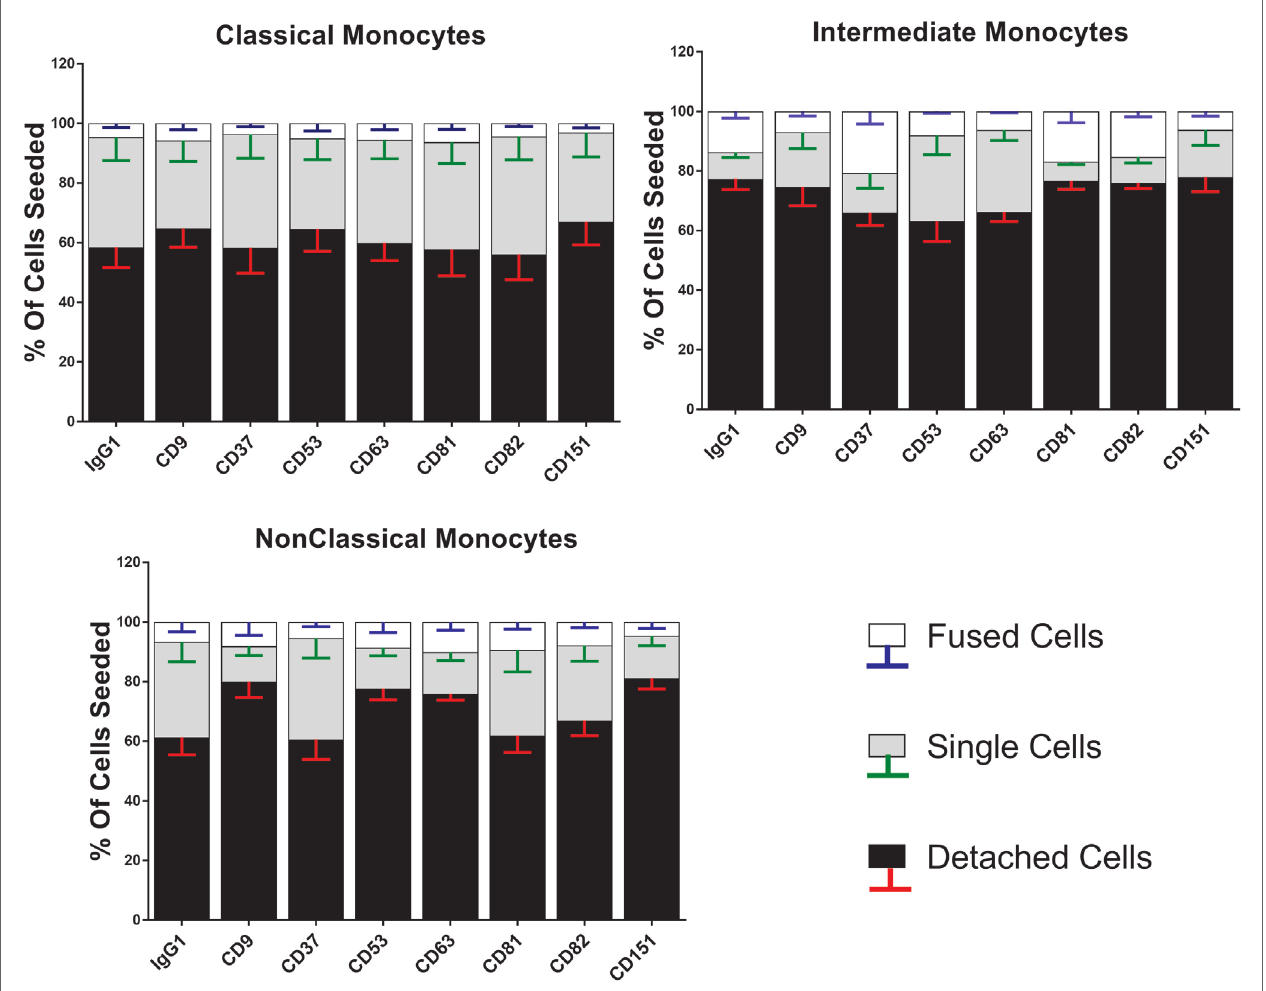
FigUre 6 | Anti­tetraspanin antibodies do not affect cell fate during concanavalin A (ConA)­induced fusion. The fate of sorted monocyte subsets was determined by counting nuclei at 72 h and expressed as a percentage of the cell numbers originally plated. Bars represent means ± SEM, n = 3–8. Significance was tested with a Kruskal–Wallis test with Dunn’s multiple comparisons test comparing the means of the same state within the same time point against the other subsets. Black bars/red error bars: detached cells, gray bars/green error bars: single cells and white bars/blue error bars: fused cells with > 3